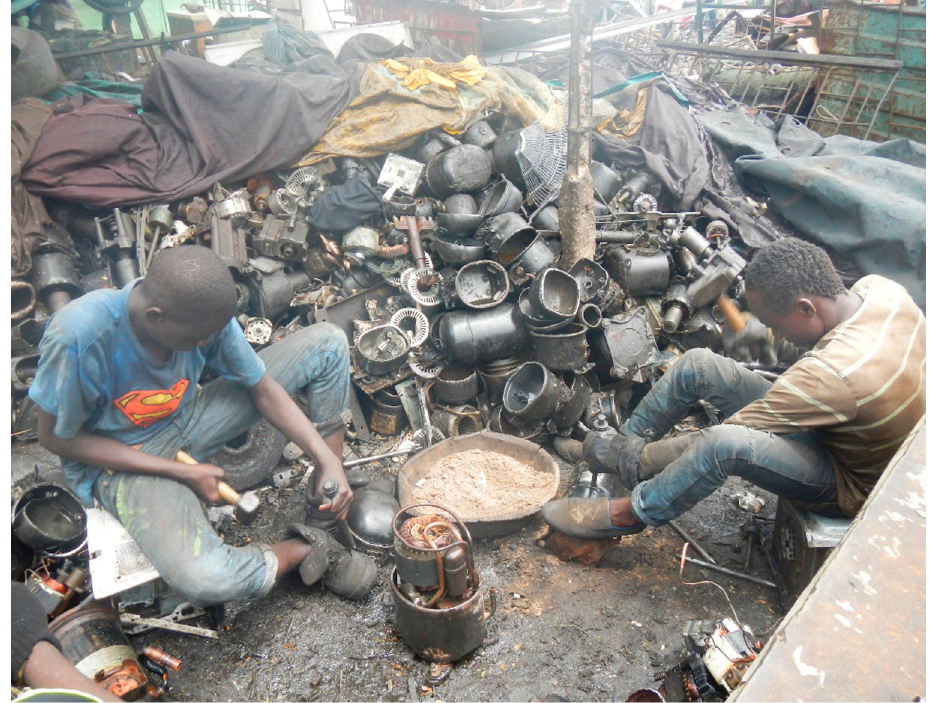
Figure 1. E-waste dismantling activities at Agbogbloshie.